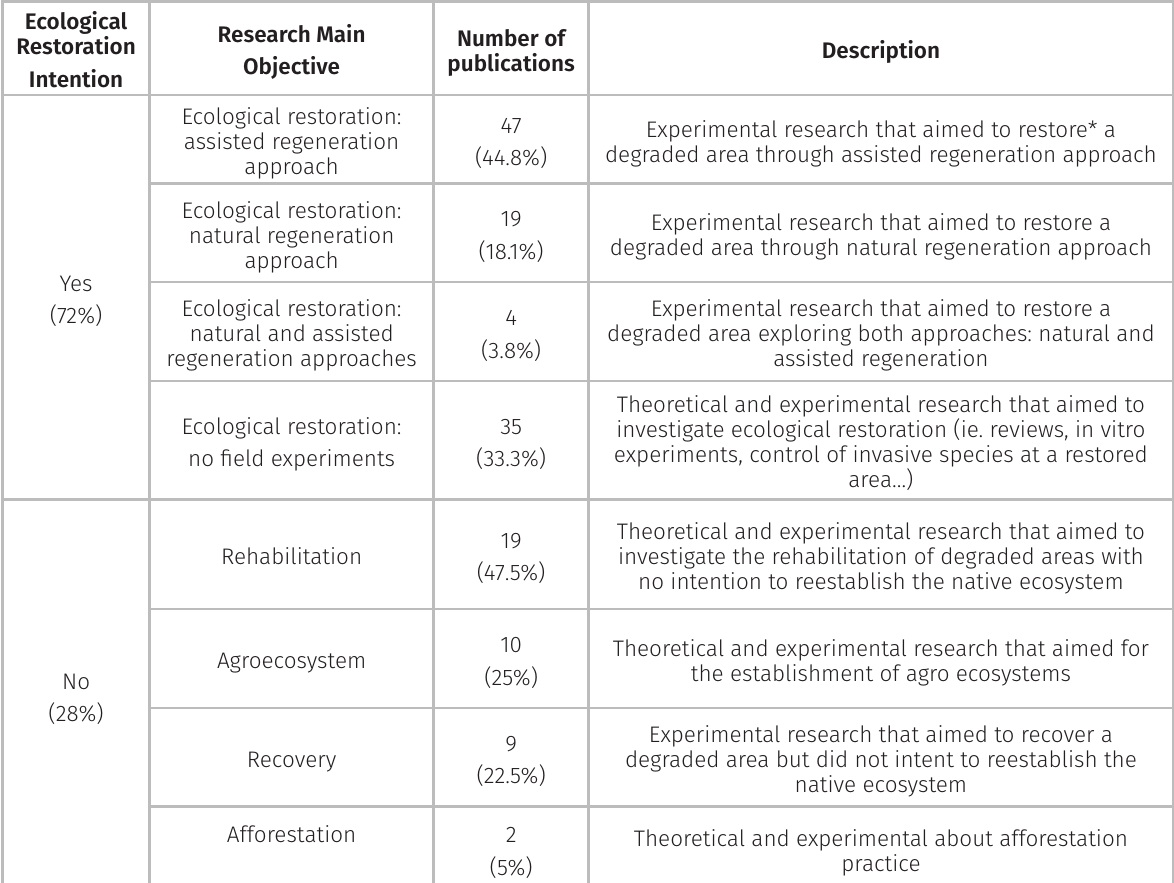
Theoretical and experimental about afforestation